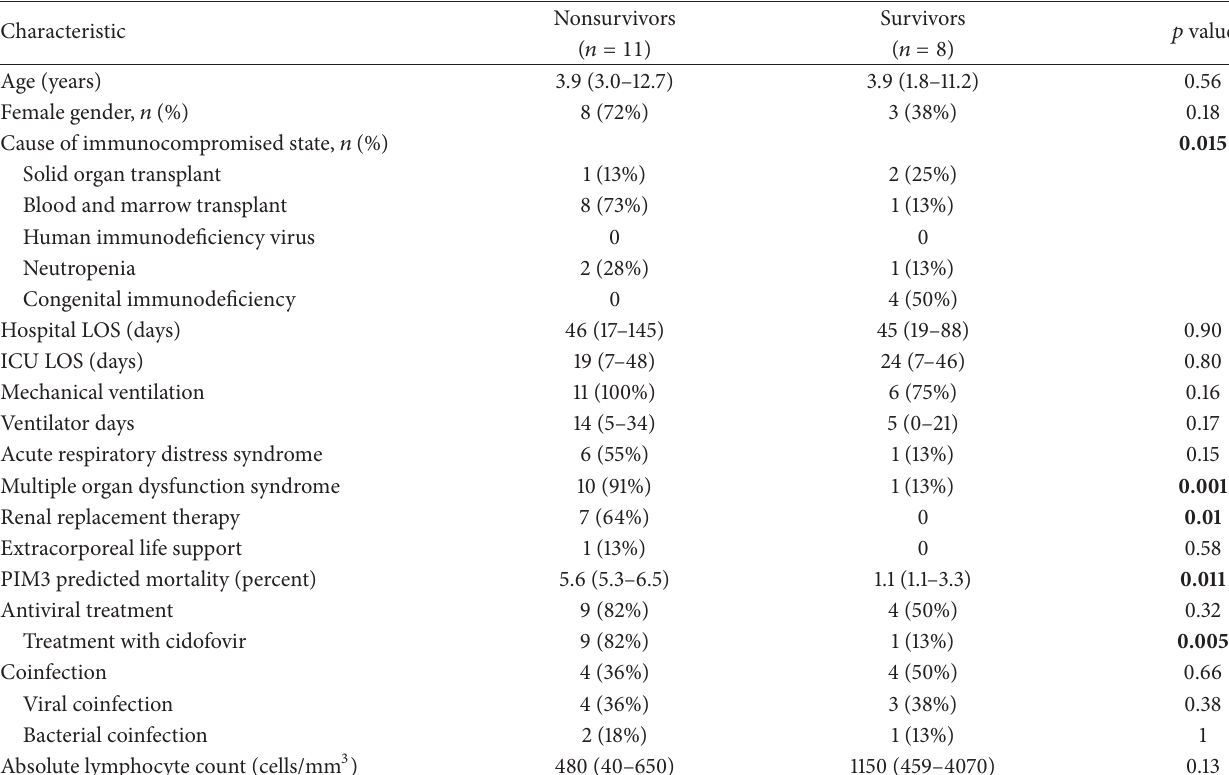
Table 3: Patient and clinical characteristics stratified by survival.